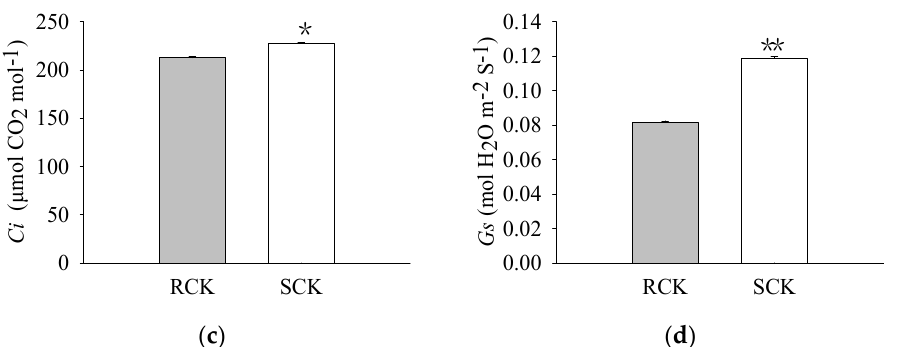
Figure 2. The photosynthetic parameters of quinclorac-resistant (RCK) and -sensitive (SCK) E. crus-galli without quinclorac treatment. ( a ) Net photosynthetic rate ( Pn ); ( b ) transpiration rate ( Tr ); ( c ) intercellular CO 2 concentration ( Ci ); and ( d ) stomatal conductance ( Gs ). * represents a statistically significant difference ( p < 0.05), and ** represents a statistically significant difference ( p < 0.01).